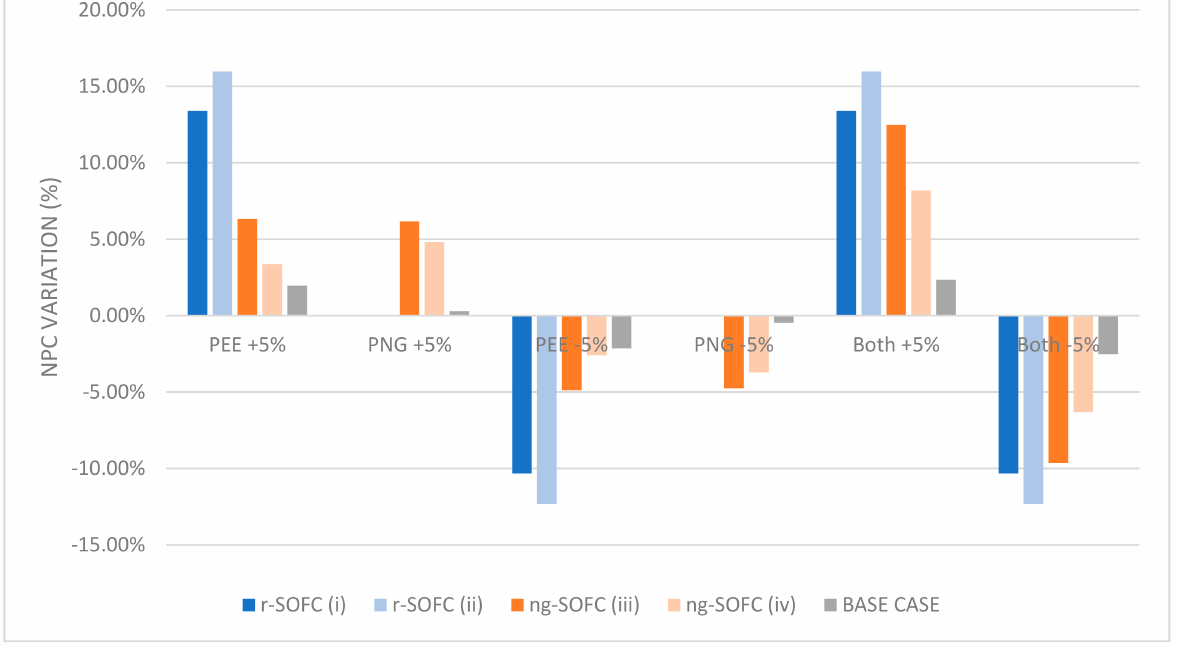
Figure 6. Sensitivity analysis (SG) with ± 5% variations of energy price. P EE : price of electricity. P NG : price of natural gas. Both: price of electricity and price of natural